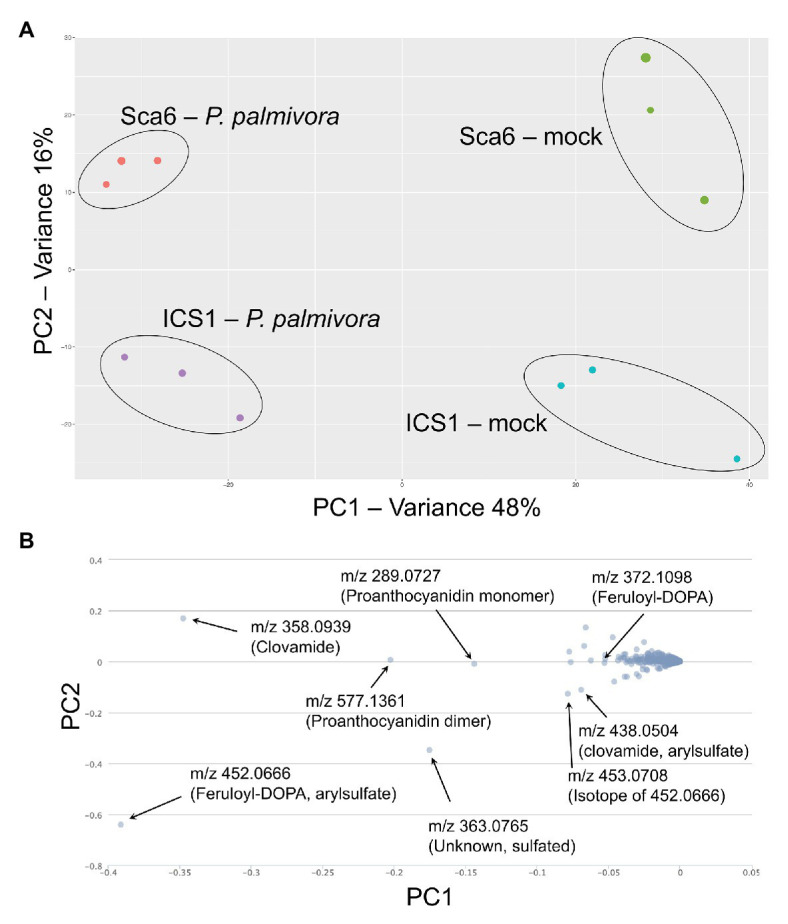
LC-MS metabolomics of pod (fruit) infection by P. palmivora overview. (A) Principle Components Analysis (PCA) of LC-MS data, P. palmivora-infected or mock inoculated. (B) Loading chart showing contribution of individual metabolite features to each principle component. Greater deviation from zero on either axis represents a larger contribution to the respective principle component. Major contributors to each principle component are indicated with median mass to charge ratios (m/z) and putative annotations. All m/z shown are suspected molecular ions ([M-H]−) except one indicated as an isotope.